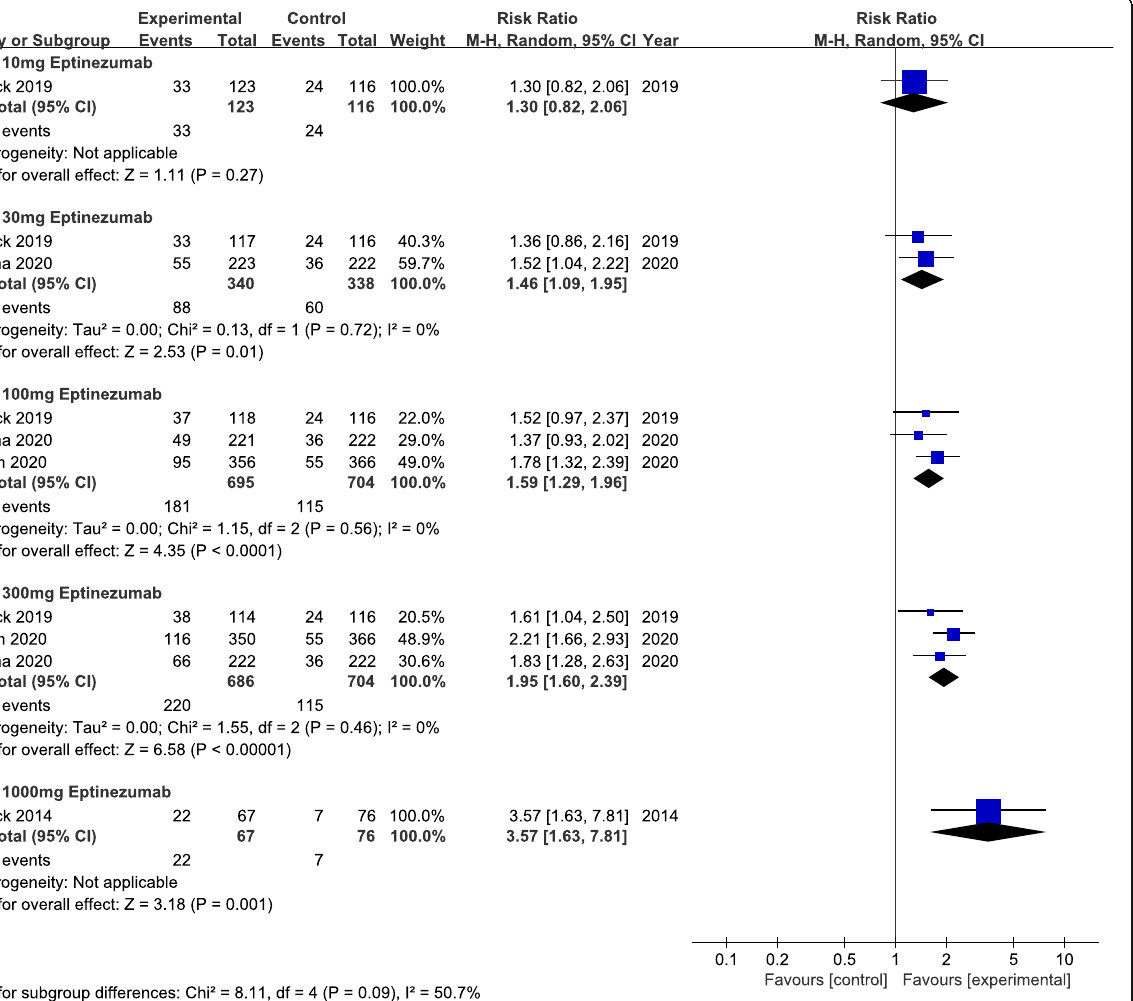
Fig. 3 The pooled risk ratio (RR) of 75% responder rate (defined as patients with a 75% reduction in migraine days from baseline) in different treatment doses compared with placebo, the diamond indicates the estimated RR with 95% confidence interval (CI) for the pooled